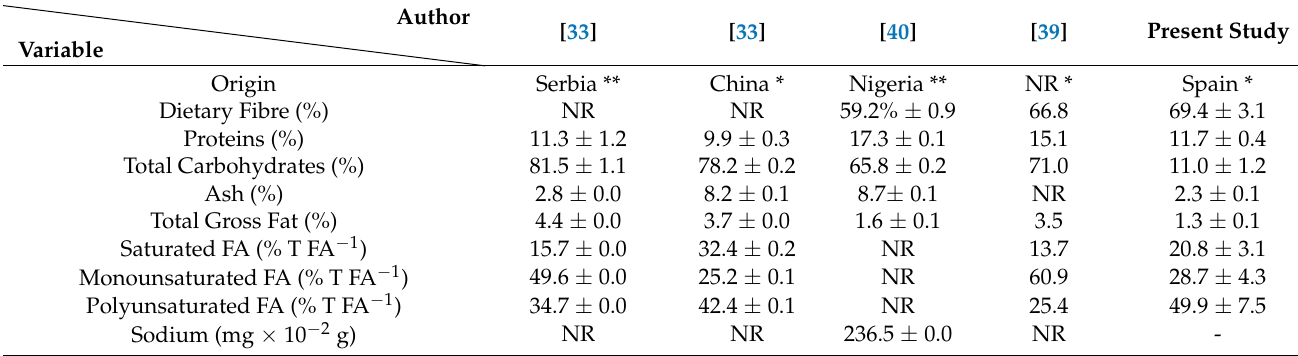
Table 4. Nutritional values for GL by different authors compared with the dry weight values found in our study.* Cultivated; ** Wild; NR: Not reported; FA: Fatty Acids. T: Total.